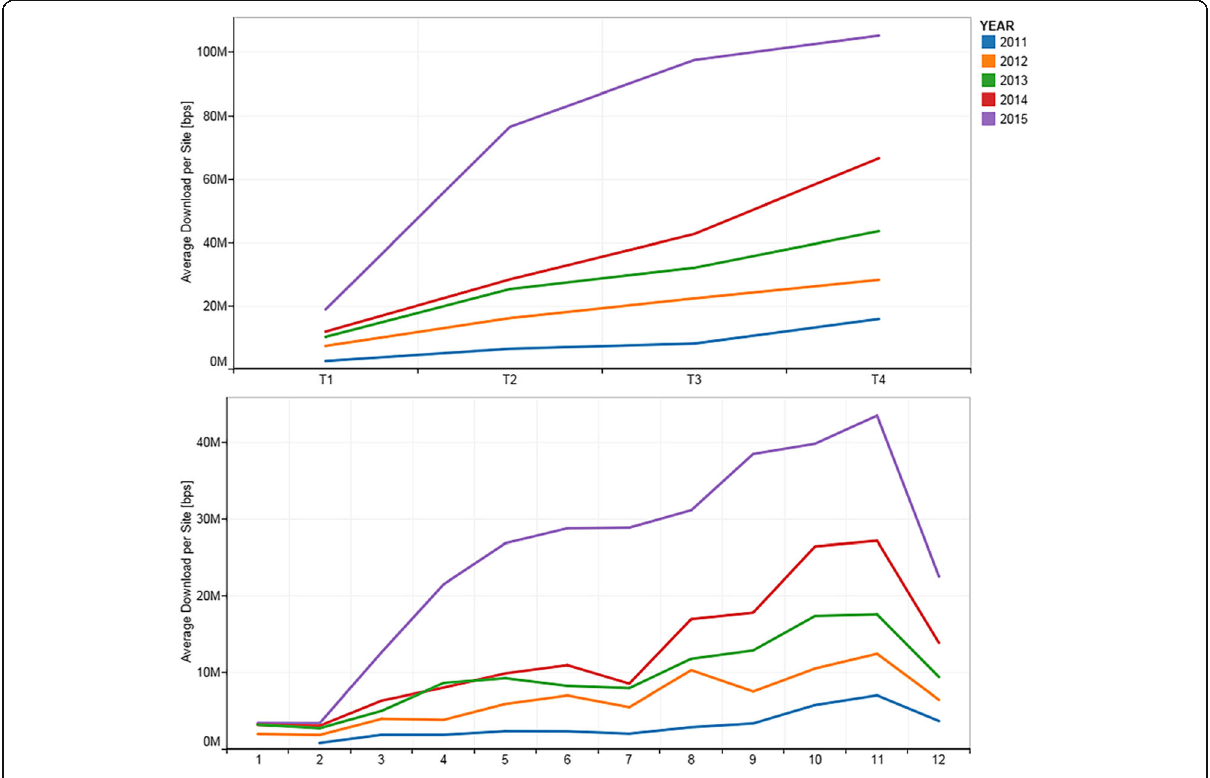
Fig. 2 Global Internet traffic download at